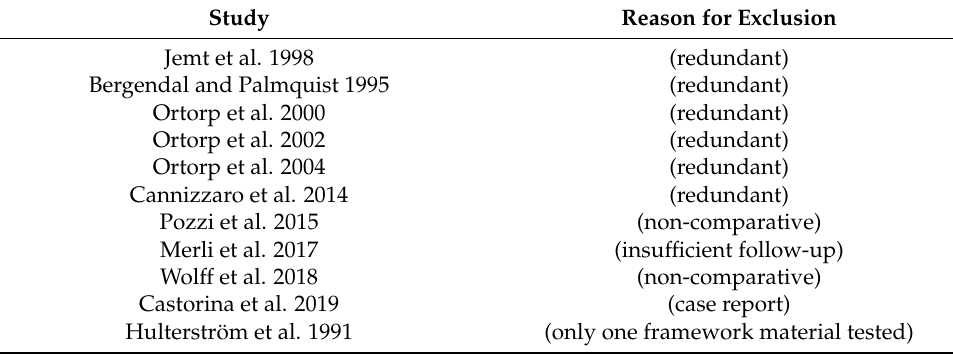
Table A1. Table reporting the 11 excluded studies and reasons for